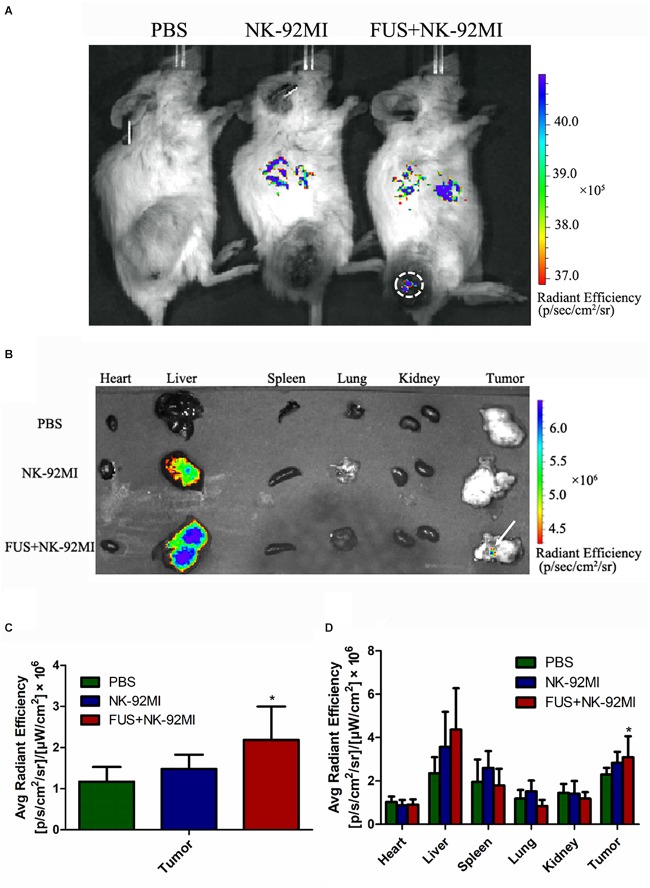
Biodistribution of NK-92MI in xenograft ovarian tumor model. (A) NCG female mice were subcutaneously injected with SKOV3 cells. On day –14, the tumors were allowed to grow to 70–100 mm3. Mice were randomly divided into three groups (PBS, NK-92MI, and FUS+NK-92MI). Then, animals were treated by intravenous injection of 107 NK-92MI stained with DiR dye. The biodistribution of NK-92MI was assessed with Caliper Spectrum IVIS system. (B) Special DiR tissue fluorescence for each organ was quantified using the Caliper Spectrum IVIS system. (C) Quantification analysis of fluorescent intensity in the PBS, NK-92MI and FUS+NK-92MI groups from panel (A). The tumor site of the FUS+NK-92MI group has stronger fluorescent intensity compared with the PBS and NK-92MI groups. (D) Quantification analysis of fluorescent intensity from different organs in panel (B). The tumor site of the FUS+NK-92MI group has stronger fluorescent intensity compared with the PBS and NK-92MI groups. ∗P < 0.05 was considered statistically significant.